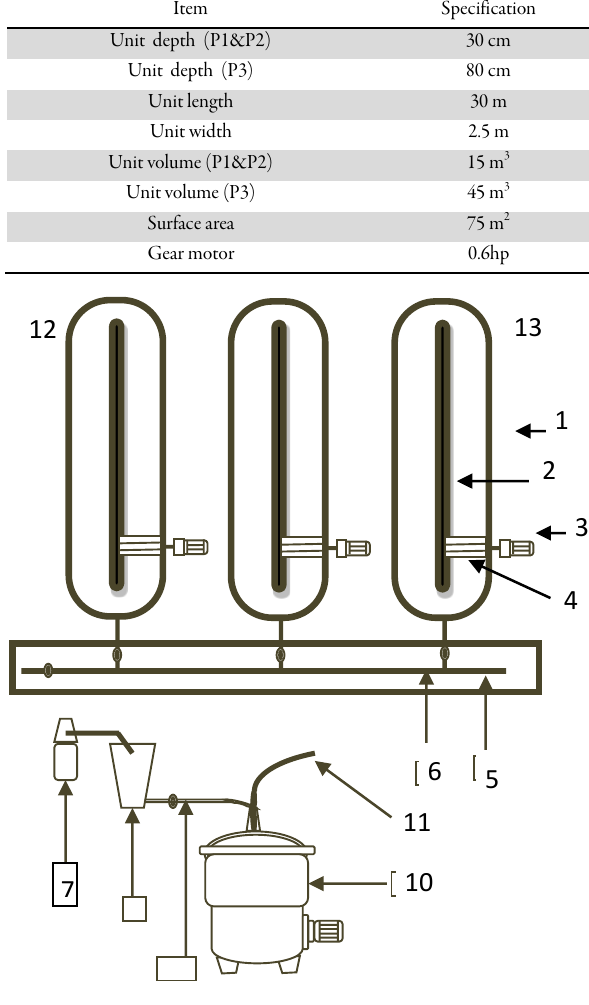
Fig. 3. Unit structure and process of Spirulina platensis production (NRC-Egypt). 1- Outer pond wall, 2- Middle separator wall, 3- Gear Motor, 4- Paddle wheal 5- Piping tunnel. 6- 75 mm Pipe, 7- Electric pump, 8- 500 L tank, 9- Feeding pipe, 10- Continuous centrifuge, 11- Drain way to the third pond (to recycle), 12- Pond 3 with 45 m 3 growth volume, 13- Pond with 15 m 3 growth volume